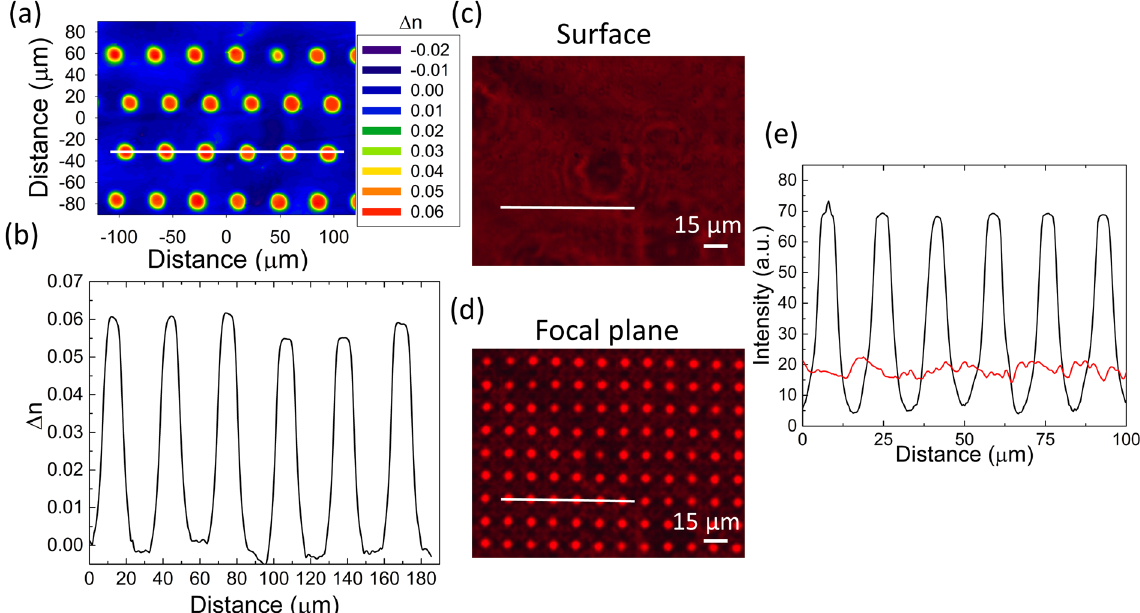
Figure 3. PHASICS map of a two-dimensional array of circles imprinted on a ChG glass with index changes ( Δ n) shown as color changes ( a ), Δ n linescan profile measured on the PHASICS map ( b ), light intensity at the surface of the sample ( c ), light intensity at the focal plane of the microlens array ( d ), comparison of intensity profiles recorded at the surface (red) and at the focal plane (black) ( e